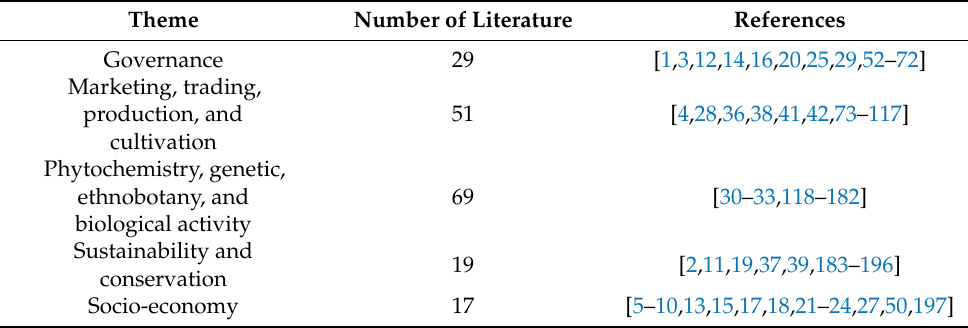
Table 1. Reviewed